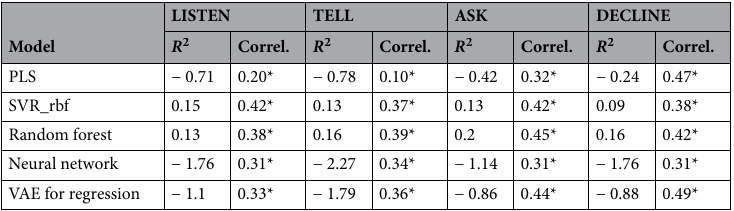
Task Label R 2 RMSE